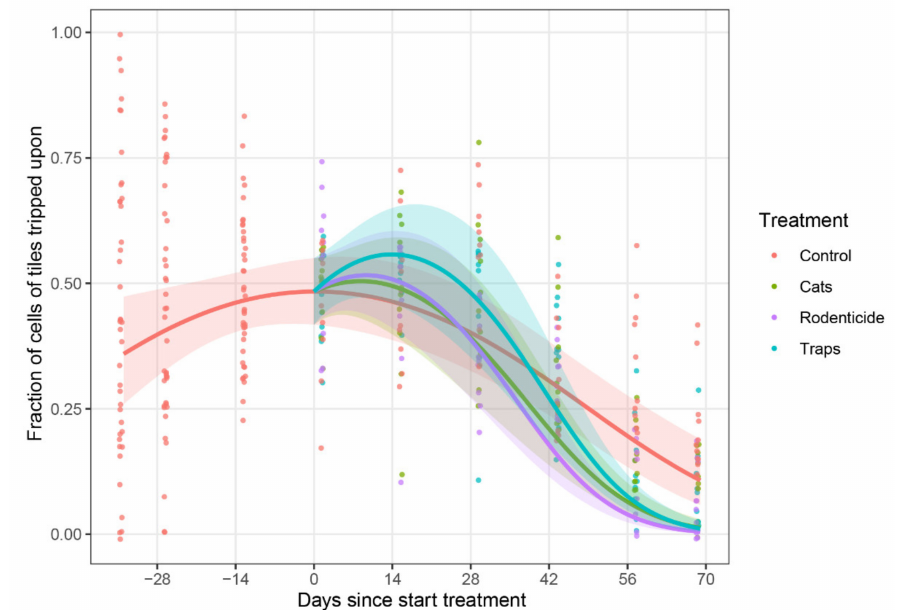
Figure 8. Percentage of tracking tiles marked with rodent footprints, using average values from two locations and two consecutive observation days ( n = 4), in the wet season of 2016. Estimated time trend lines for each treatment were generated by a generalised linear mixed model (described in M&M), with shaded areas representing 95% confidence bands for the predicted mean response, indicating that treatments had an e ff ect on reducing rodent losses compared to the untreated control by the end of the storage